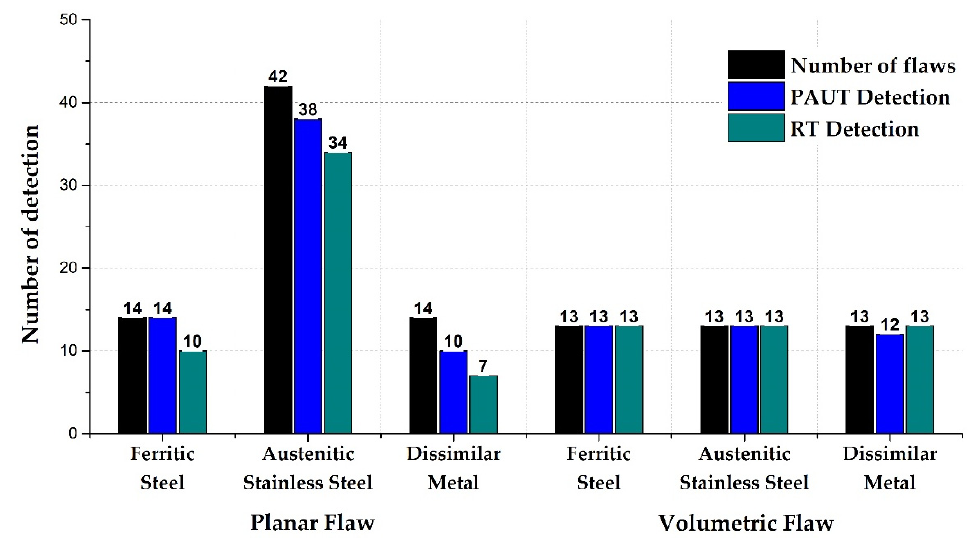
Figure 7. Comparison of the flaw detection performance between RT and PAUT according to the flaw type and materials.